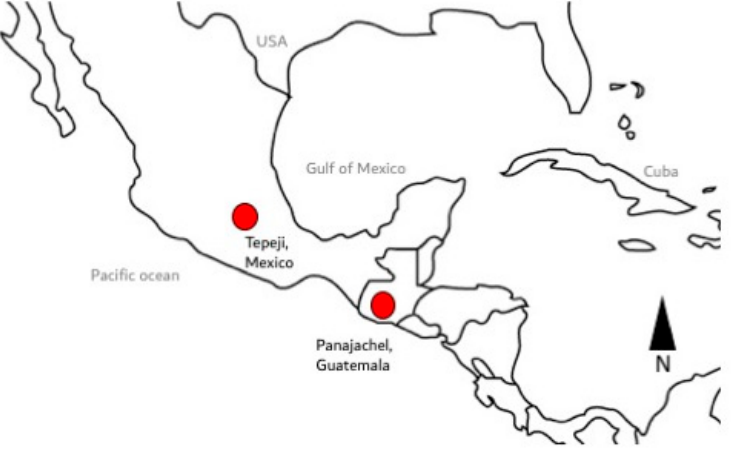
Figure 2. Location of the pilot sites.